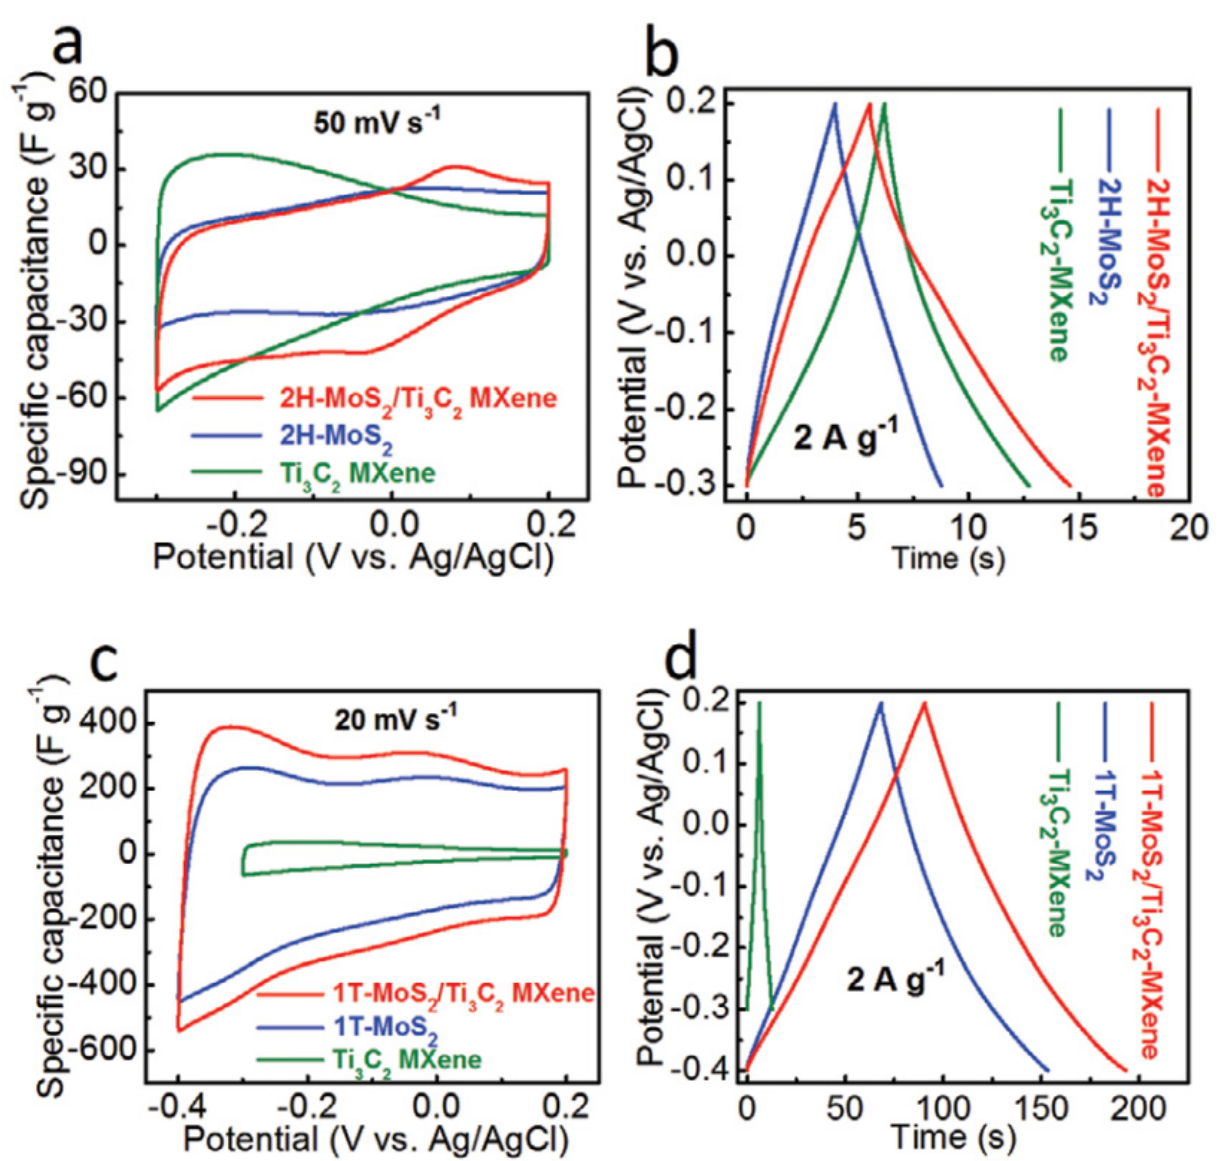
Figure 10. Electrochemical performance of 2H-MoS 2 , 1T-MoS 2 , Ti 3 C 2 MXene, 2H-MoS 2 /Ti 3 C 2 MXene, and 1T-MoS 2 /Ti 3 C 2 MXene electrodes from ref. [88]. ( a ) Specific capacitance of the electrode at 50 mVs − 1 scan rates ( b ) GCD curves of the electrodes at 2 A g − 1 current density of 2H-MoS 2 /Ti 3 C 2 MXene, ( c ) Specific capacitance of the electrode at 20 mVs − 1 scan rates, ( d ) GCD curves of the electrodes at 2 A g − 1 current density of 2H-MoS 2 /Ti 3 C 2 MXene. Copyright 2020 Wiley.